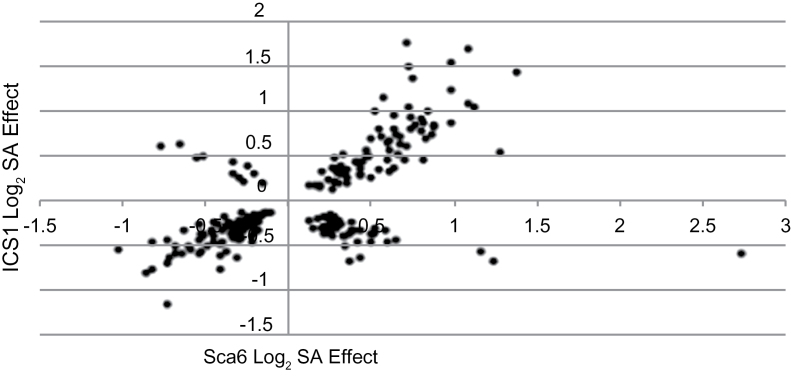
Gene induction differences in Sca6 and ICS1. X-axis represents log2 expression change in SA-treated versus water-treated Sca6 leaves, after obtaining the general linear model mean of differences across leaf stages. Y-axis represents log2 expression change in SA-treated versus water-treated ICS1 leaves, after obtaining the general linear model mean of differences across leaf stages. Points represent the 234 genes with statistically significant (BH P<0.05) expression changes in both genotypes.